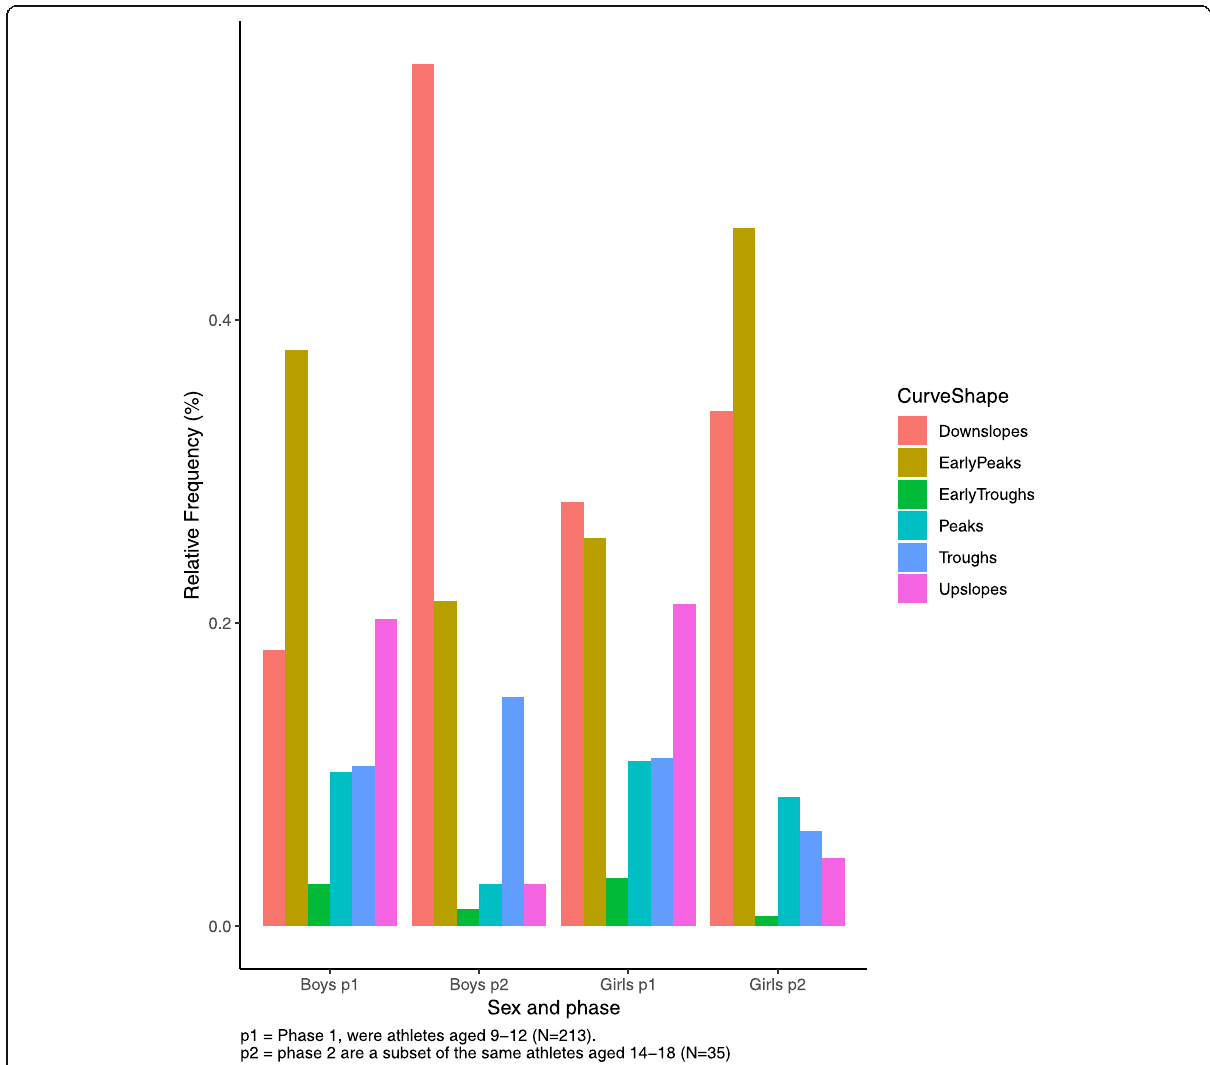
Fig. 7 Relative frequencies of each shape according to sex and